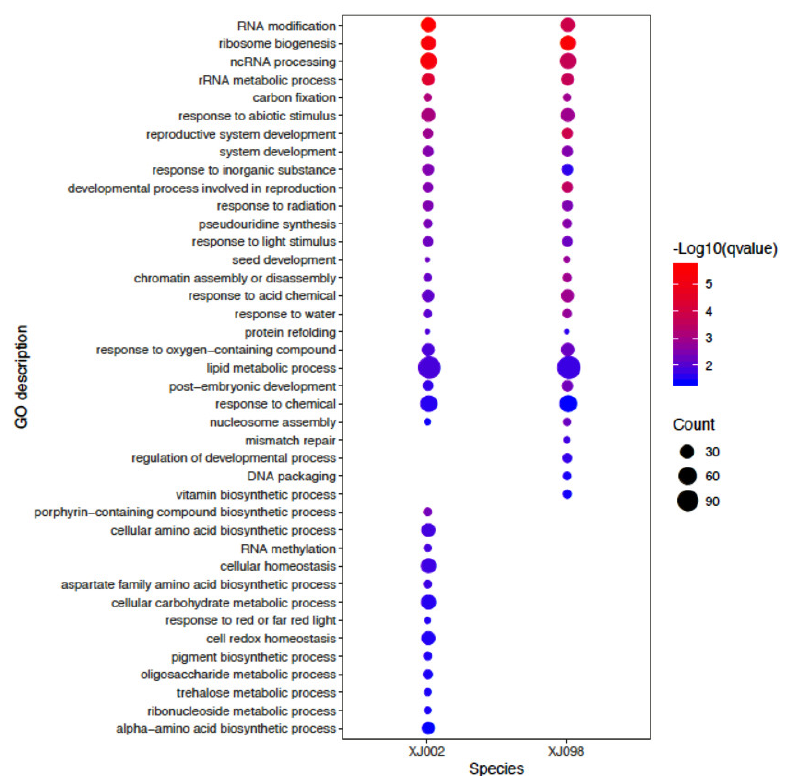
Figure 5. Categories and distribution of GO terms in the XJ002 and XJ098 under control and drought stress.